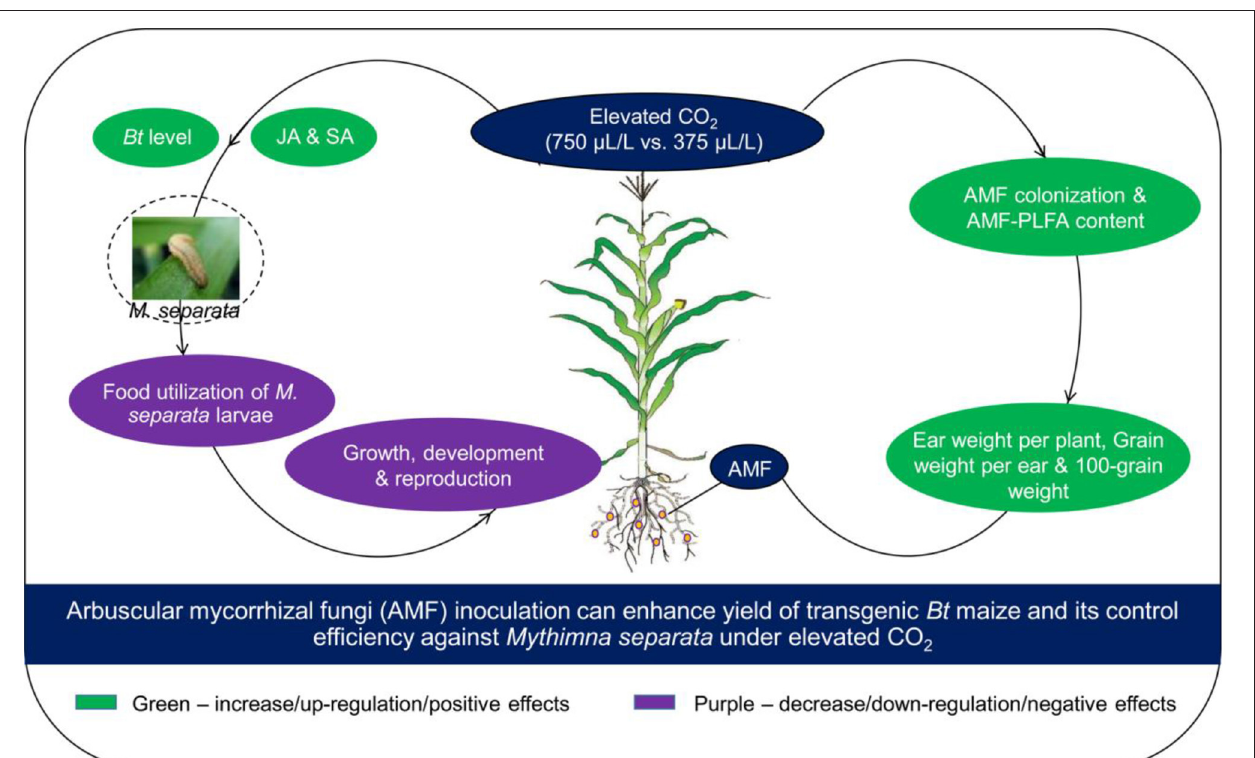
FIGURE 8 | A schematic model that AMF inoculation can enhance the yield of transgenic Bt maize and its control efficiency against M. separata under elevated CO 2